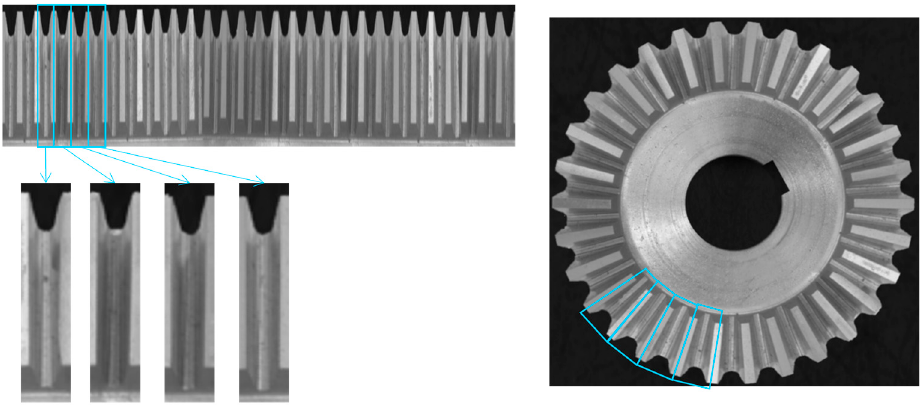
Figure 6. Tooth extraction from the stripe and visualization of the teeth in the original circularly symmetric image of the gear wheel.